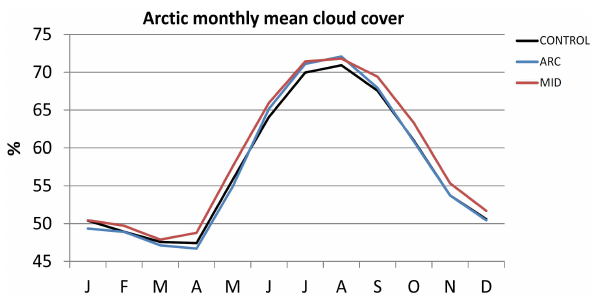
Fig. 8. Monthly Arctic mean cloud cover (in %) for the CONTROL run (black), the ARC experiment (blue) and the MID experiment